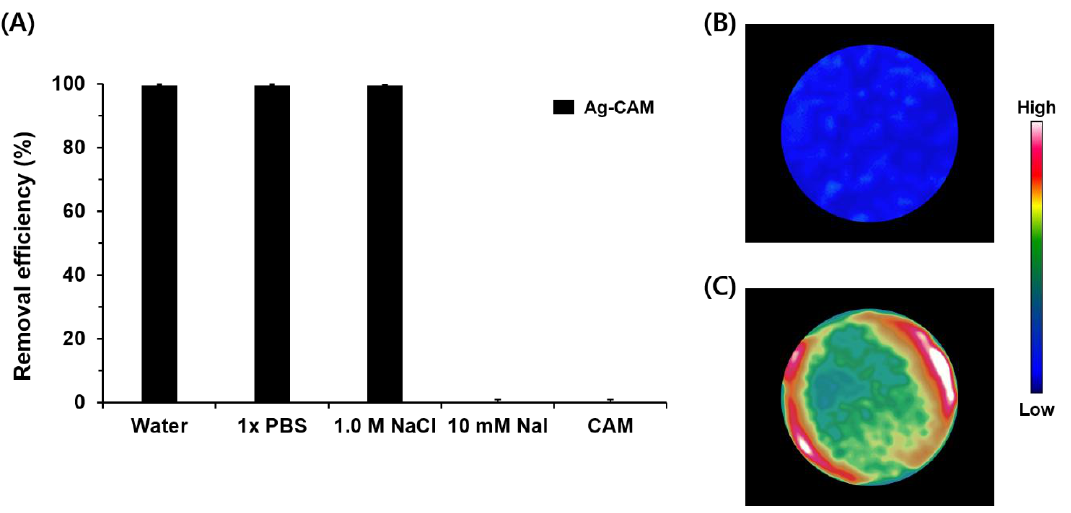
Figure 3. ( A ) Desalination of radioactive iodine using Ag-CAM in several aqueous solutions; ( B ) SPECT image of post-filtration non-modified CAM; and ( C ) SPECT image of post-filtration Ag-CAM.